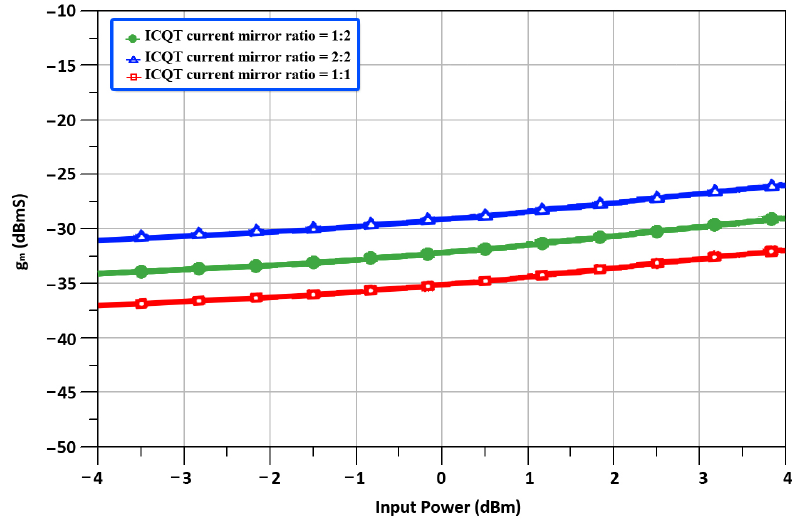
Figure 8. Transconductances of ICQT with different current mirror ratios. A small signal model of the DTP stage of the mixer is presented in Figure